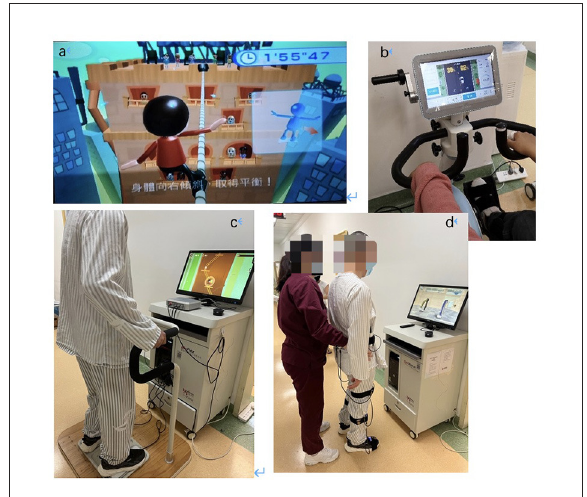
FIGURE1 Examples of VR interventions. (a) Wii exergame training; (b) an active and passive trainer with a VR screen; (c) a VR balance training system; (d) lower extremity training in a VR gait training